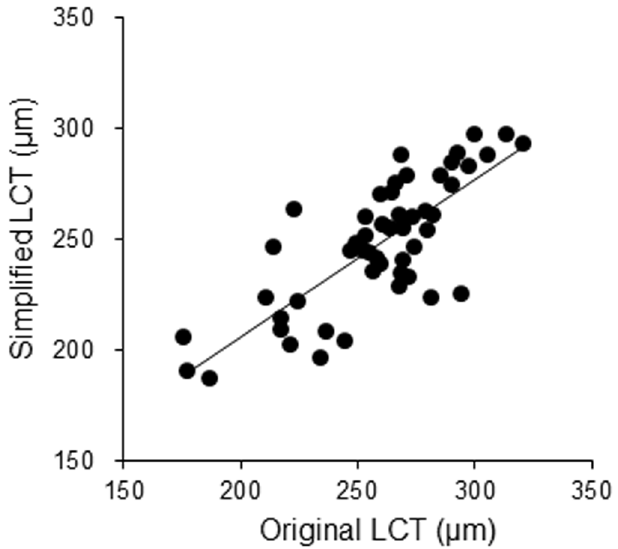
Fig 5. The correlation between measurements of lamina cribrosa thickness (LCT) made with the original and simplified versions of the software. Scatter plot graph showing the correlation of LCT measurements made with the original and simplified versions of the software. Note: the correlation coefficient between LCT measurements made with the original and simplified versions was 0.71 ( P <